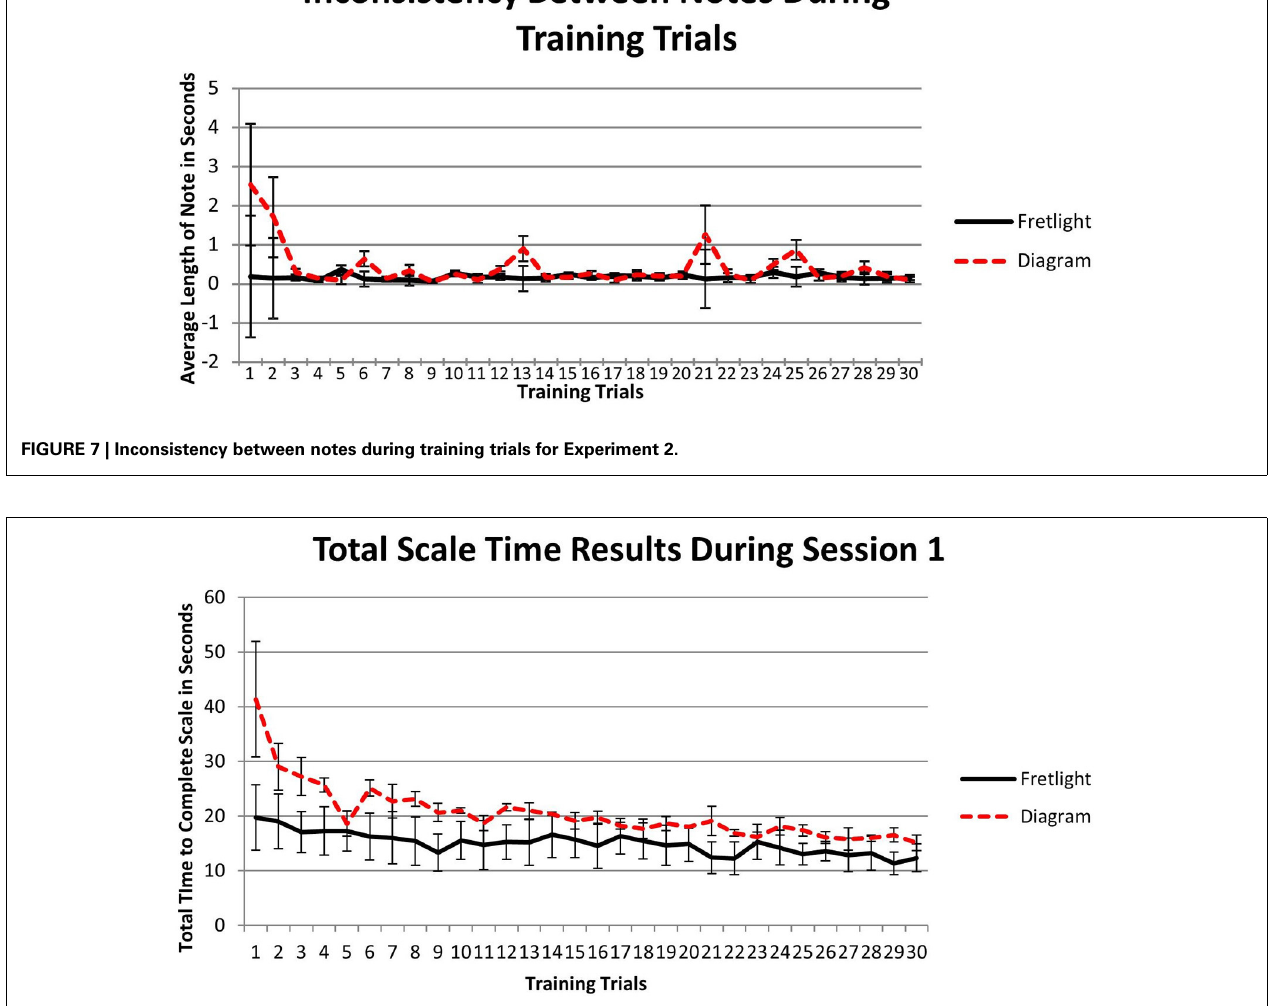
FIGURE 8 | Time to complete each training trial by learning